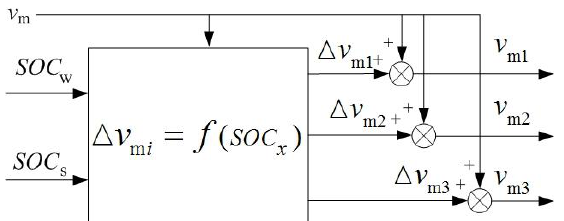
Figure 6. Block diagram of the active power-sharing method.